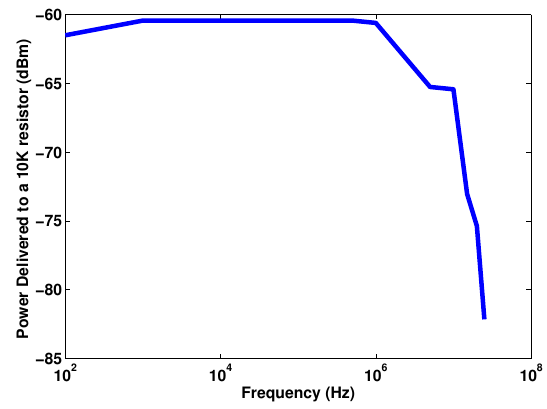
Figure 7: The large signal frequency response of CMOS